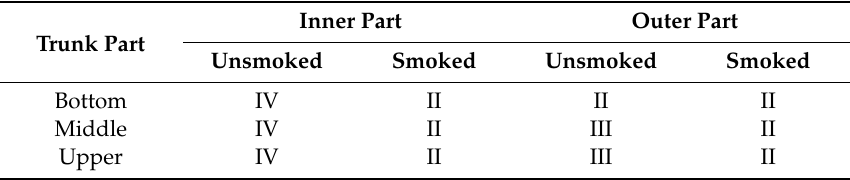
Table 8. Wood resistance class after exposure to decay